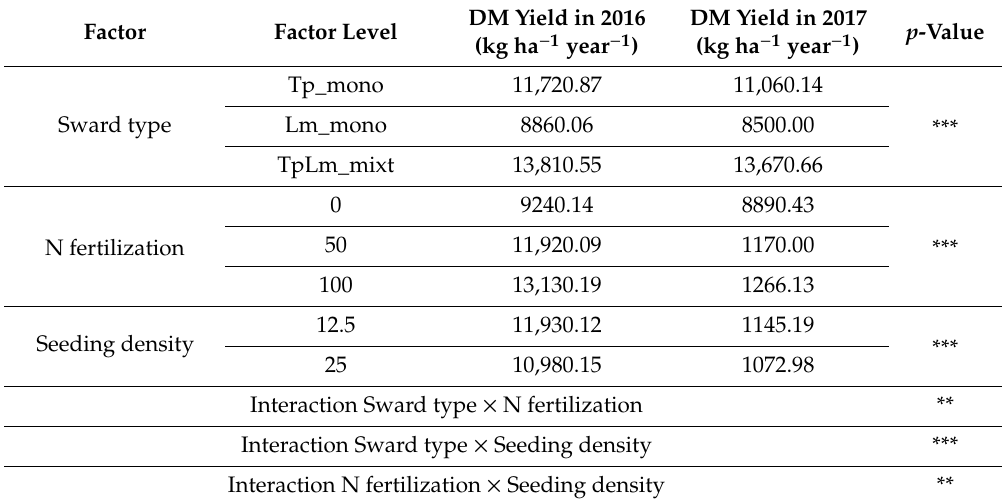
Table 3. E ff ect of nitrogen fertilization, sowing spacing between rows and sward type on the dry matter yield in 2016 and 2017.